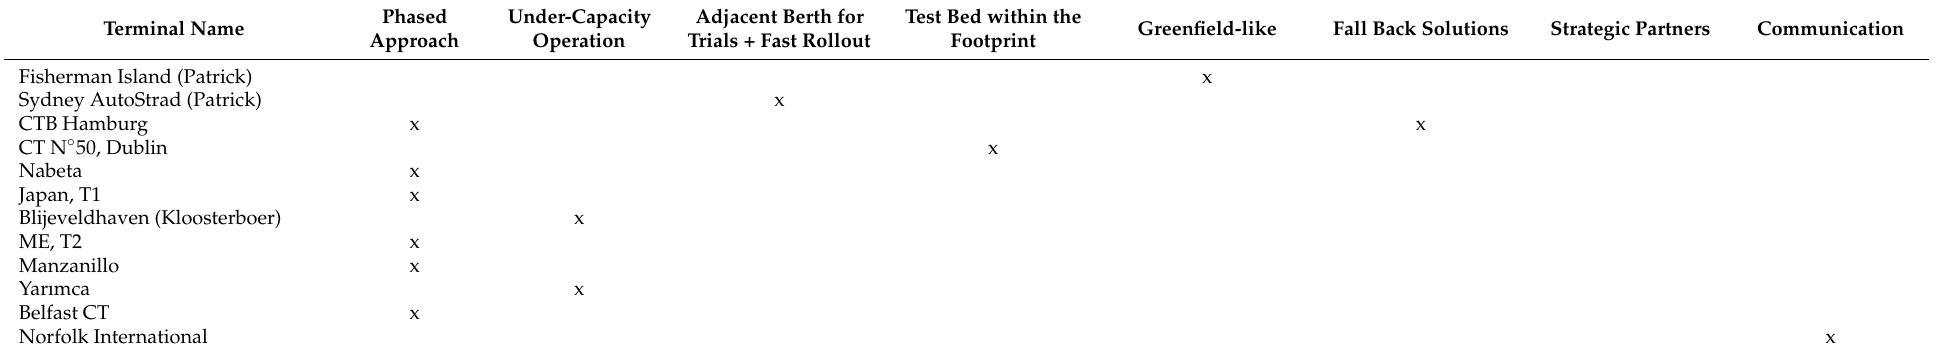
Table A3. Strategies to overcome the challenge of continuity identified from questionnaire responses.